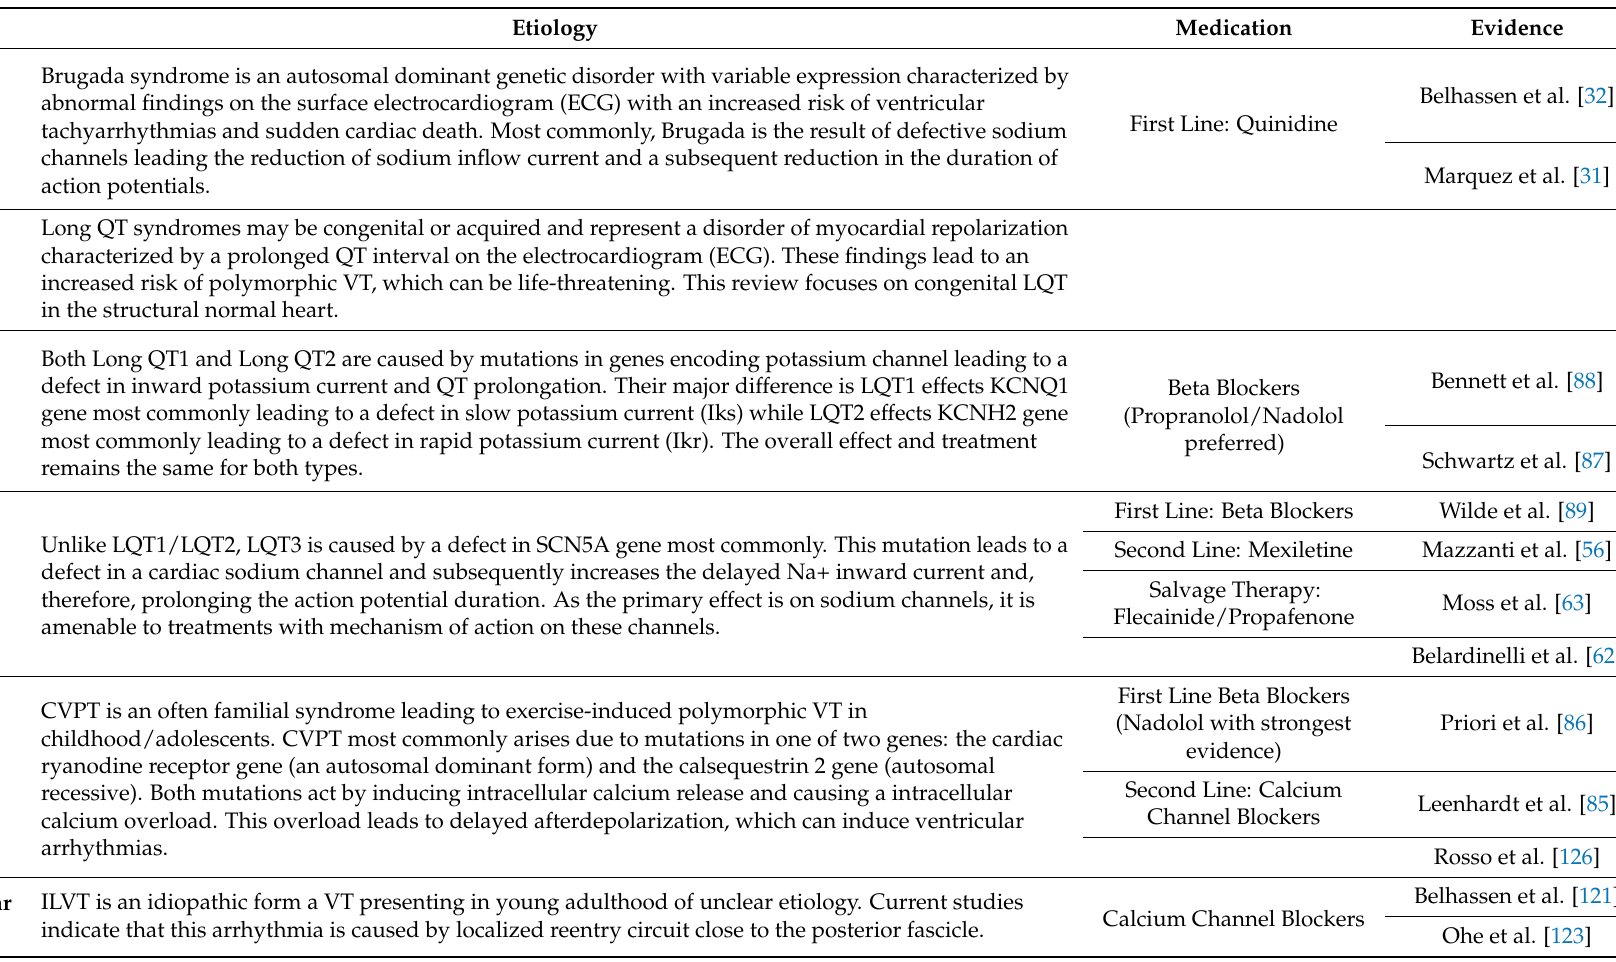
Table 2. Pharmacologic therapy in ventricular arrhythmia syndromes with structurally normal